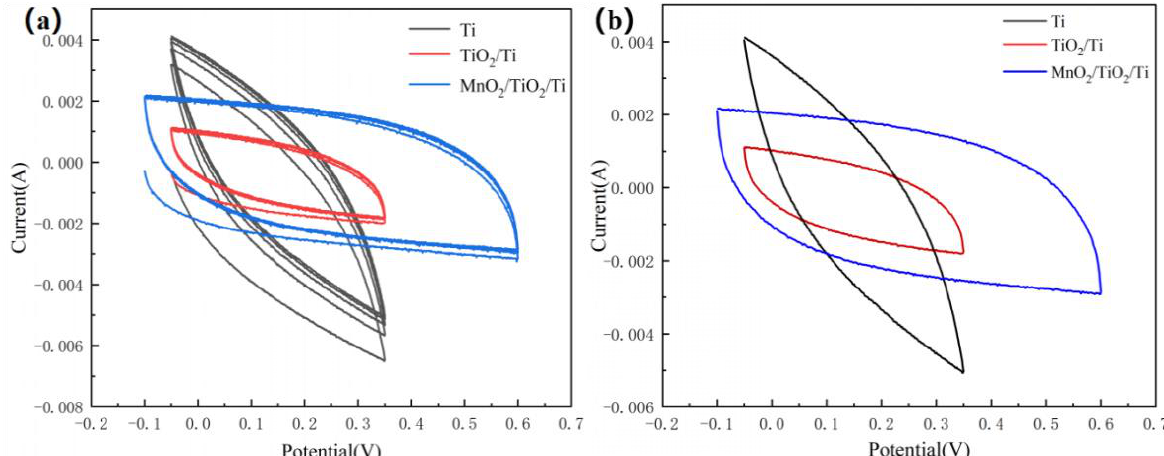
Figure 6. ( a ) Cyclic voltammetry of commercialized metal porous Ti, surface-modified TiO 2 /Ti, and MnO 2 /TiO 2 /Ti nanocomposites. ( b ) Graph of the test results for one cycle.